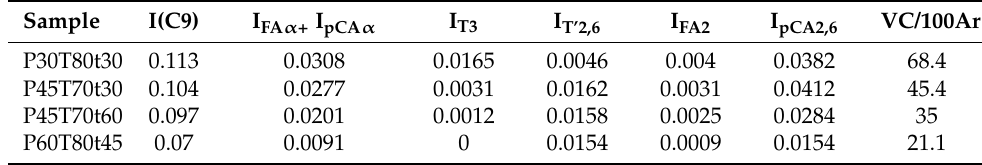
Table 5. The number of olefin carbon (VC)